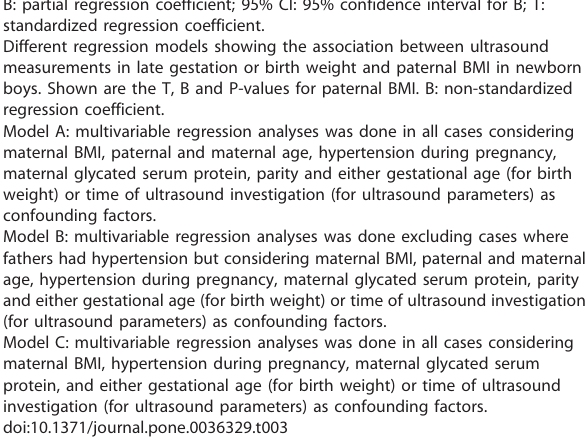
maternal BMI, hypertension during pregnancy, maternal glycated serum protein, and either gestational age (for birth weight) or time of ultrasound investigation (for ultrasound parameters) as confounding factors.